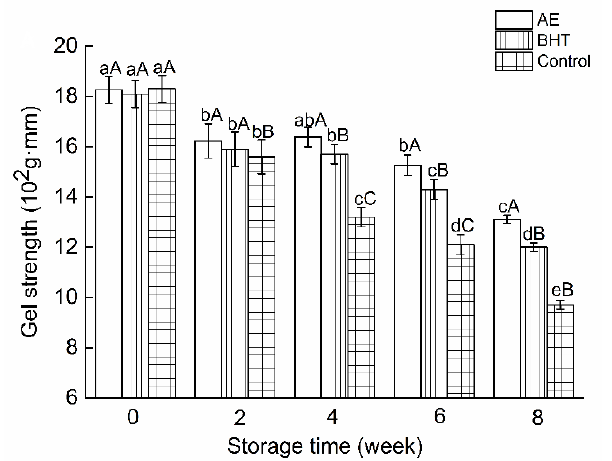
Figure 4. Changes in gel strength of shrimp surimi products with AE, BHT, and control during frozen storage. Different lowercase letters indicate the results that differ significantly with different storage times ( p < 0.05). Different capital letters indicate the results that differ significantly with different treatments ( p < 0.05).